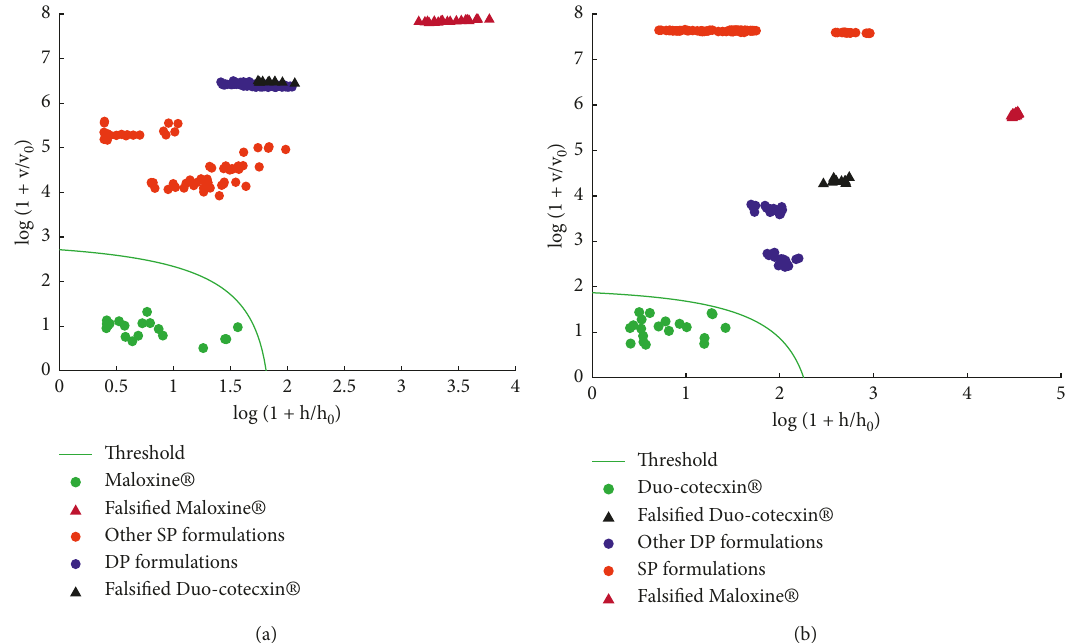
Figure 4: Data driven soft independent modelling of class analogy (DD-SIMCA) plots. (a) Maloxine ® (two PCs, α 10 − 7 Cotecxin ® (two PCs, α (cid:31)